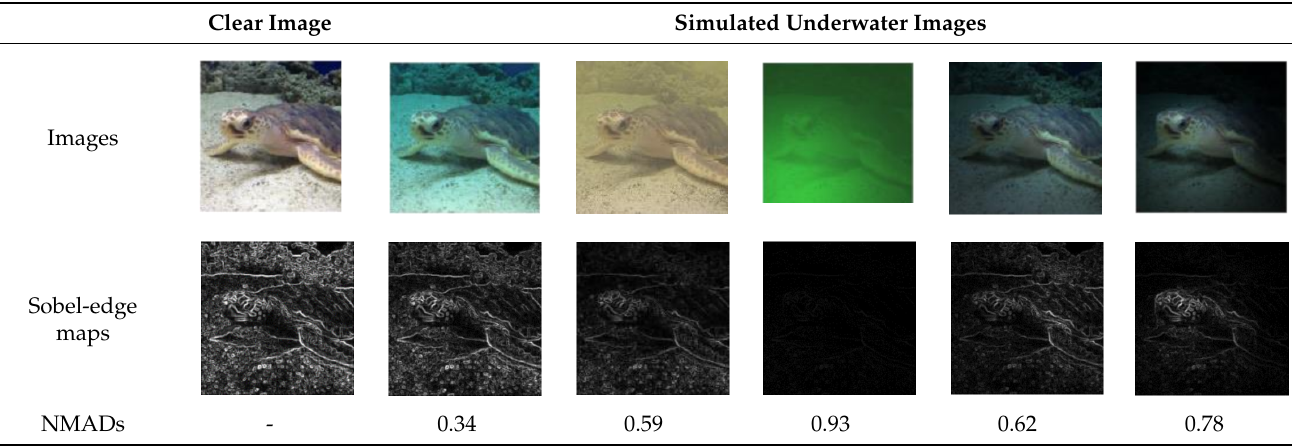
Table 2. Sobel edge maps of a clear image and simulated degraded images and their NMAD scores.